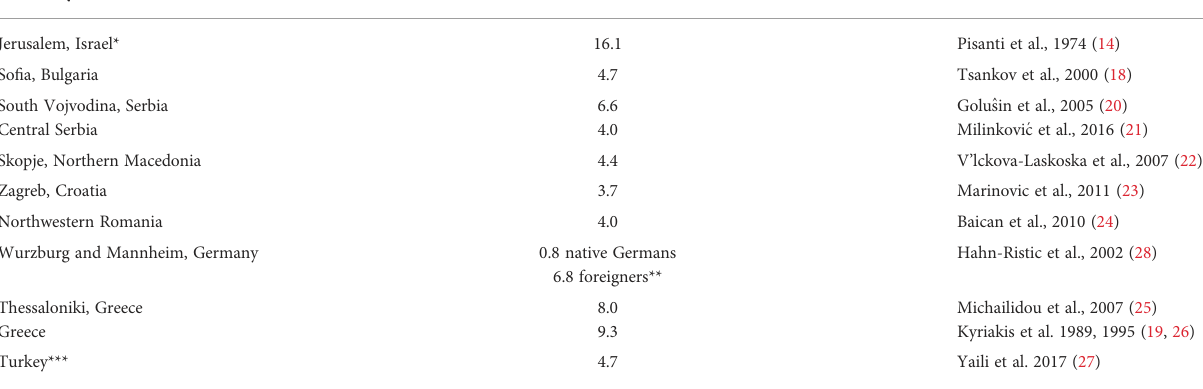
TABLE 1 Incidence of pemphigus vulgaris in Southern-European (Balkan) countries. Country Annual incidence rate/million